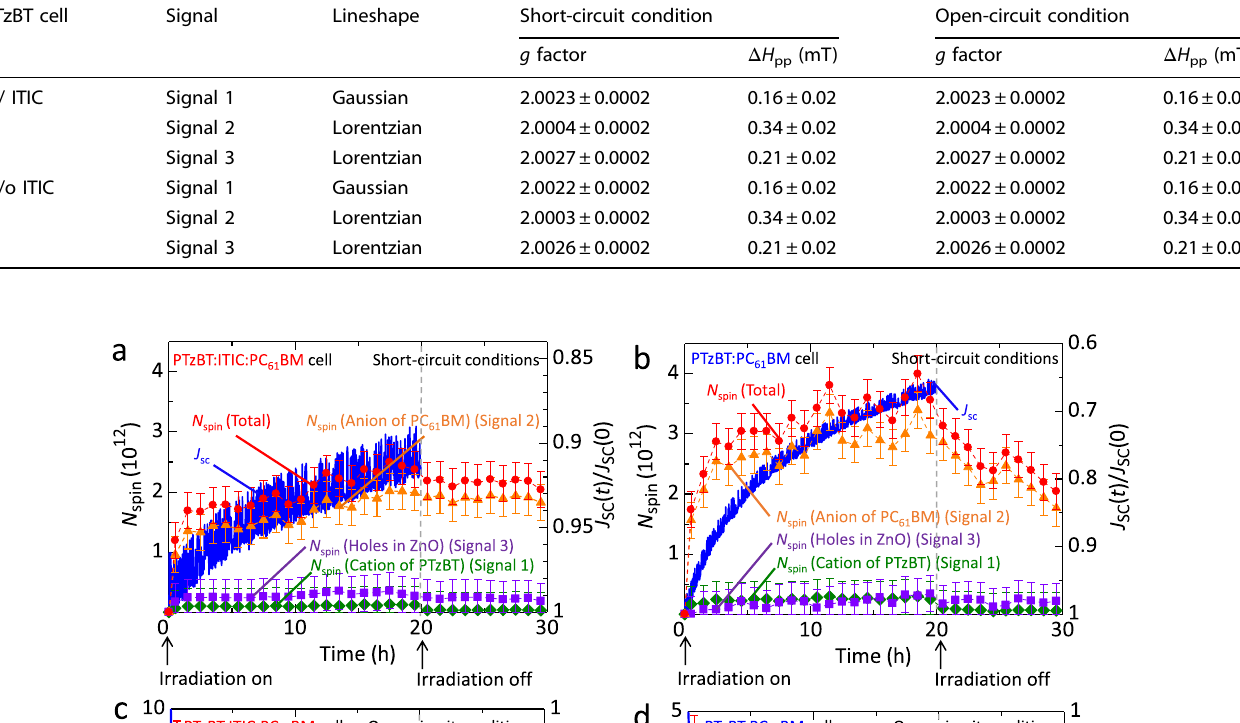
Table 2. Results of fi tting analyses of g factors and Δ H pp of Signal 1, Signal 2, and Signal 3 of PTzBT solar cells with and without ITIC under short- or open-circuit